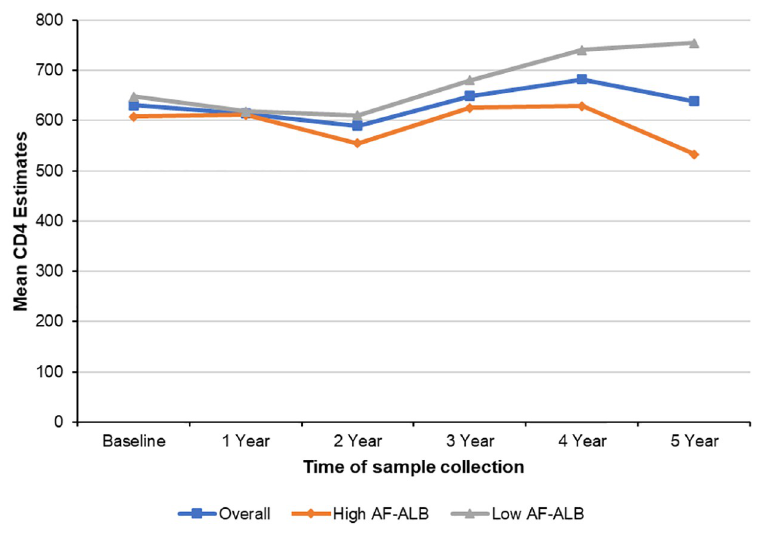
Fig 1. Mean CD4 estimates over time by baseline AF-ALB levels.